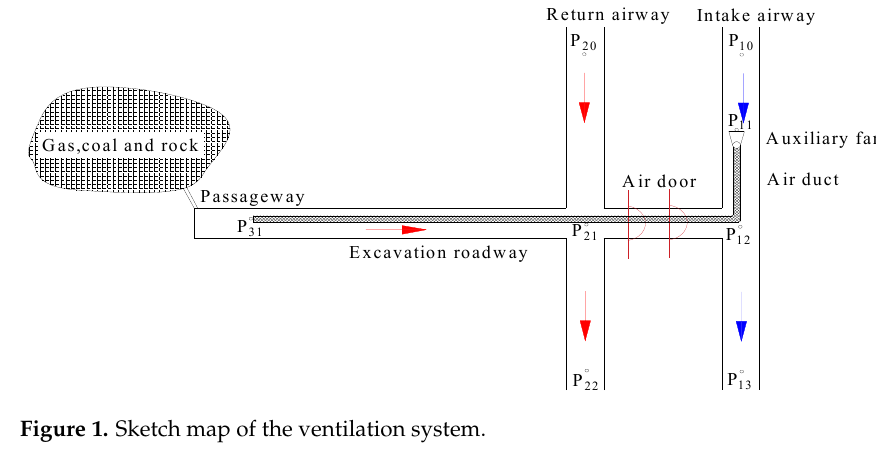
Figure 1. Sketch map of the ventilation system.